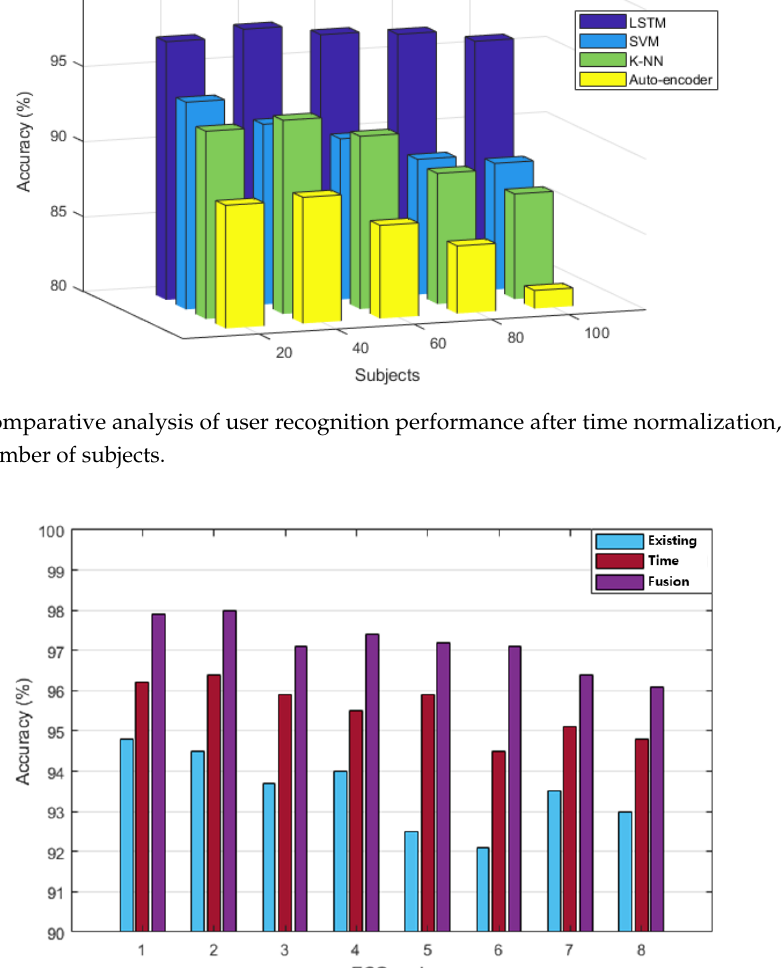
Figure 11. Comparative analysis of user recognition performance after time normalization, with an increasing number of subjects.